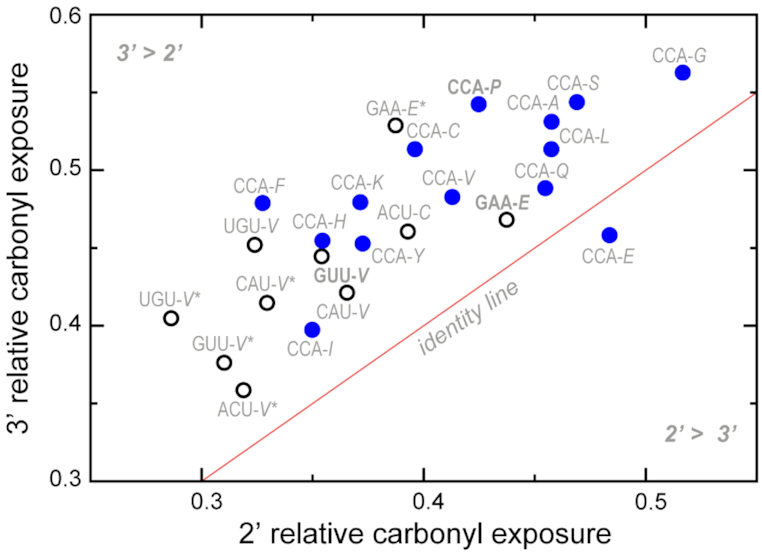
Carbonyl solvent exposure in different systems. Average relative carbonyl exposure of 2′- and 3′-isomers in the case of CCA (blue) and non-CCA (open black) trinucleotides with different amino acids attached. D-amino acids are labeled with a star. Aminoacylated trinucleotides involving cognate pairs of amino acids and their codons are labeled in bold.